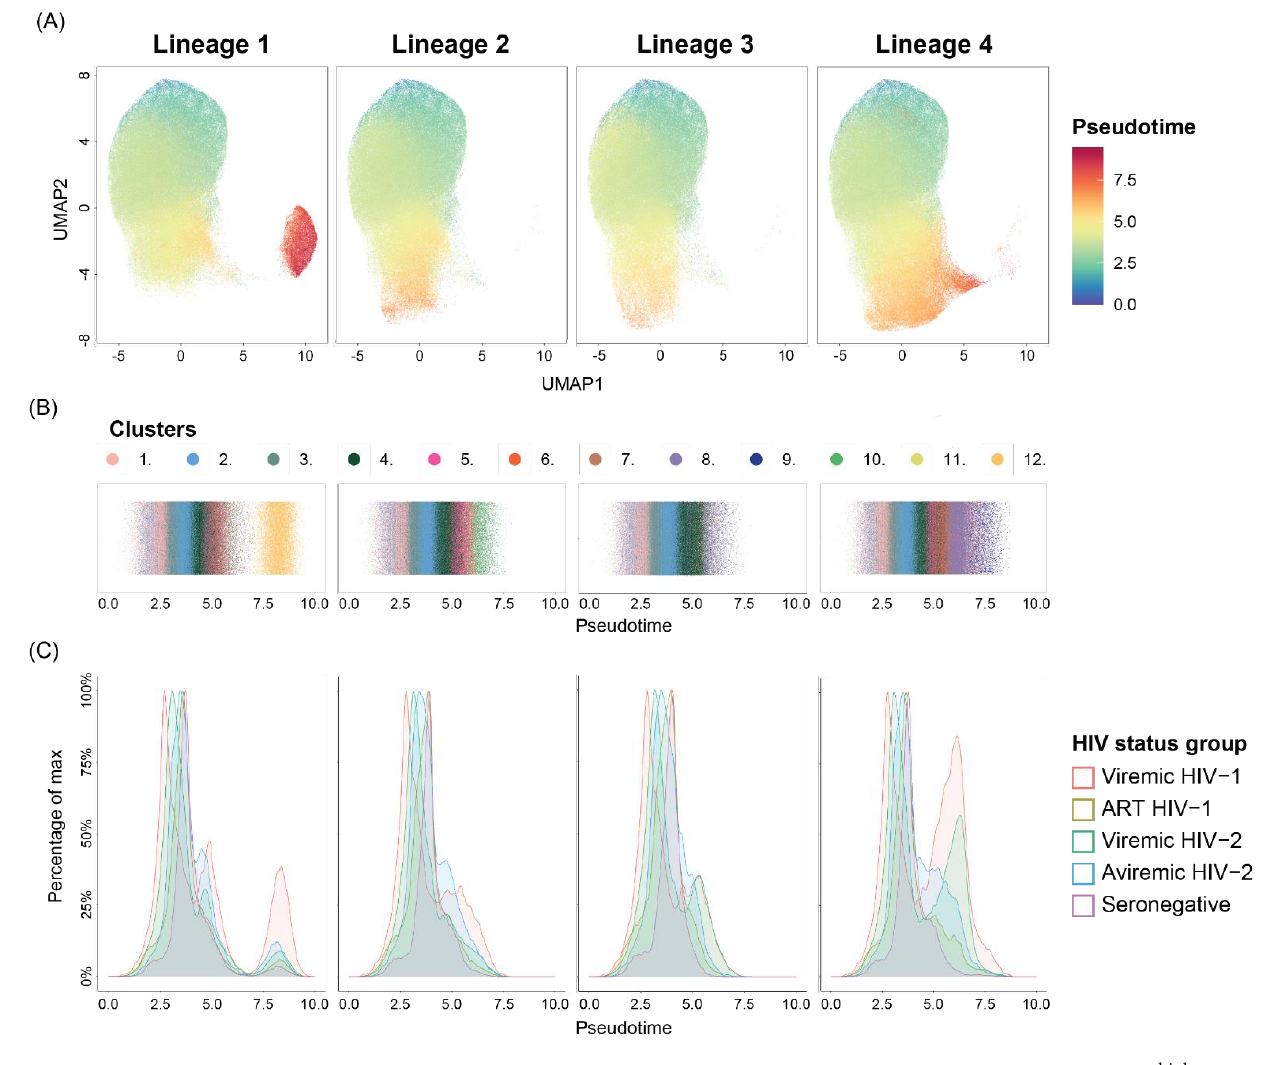
Figure 4. HIV-1 and HIV-2 infection promotes differentiation of B-cells into T-bet high activated memory B-cells. ( A ) Pseudotime projected on UMAP plots faceted by identified lineage. The pseudotime trajectory inference analysis, based on FlowSOM clusters, was performed using the Slingshot method. Fifty thousand cells from each HIV status group were included in the analysis. ( B ) Jitterplots colored by FlowSOM clusters along pseudotime in each lineage. ( C ) Lineage faceted density plots displaying the distribution of cells along pseudotime, from treatment-naïve or sub- optimally ART-treated HIV-1 (viremic HIV-1, n = 8), successfully ART-treated HIV-1 (ART HIV-1, n = 7), viremic HIV-2 (viremic HIV-2, n = 8), aviremic HIV-2 (aviremic HIV-2, n = 12)-infected individuals and HIV seronegative (seronegative, n = 25) individuals.